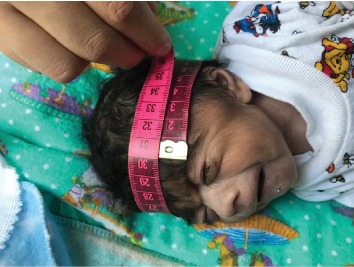
Head circumference: 30 cm (<3rd percentile).